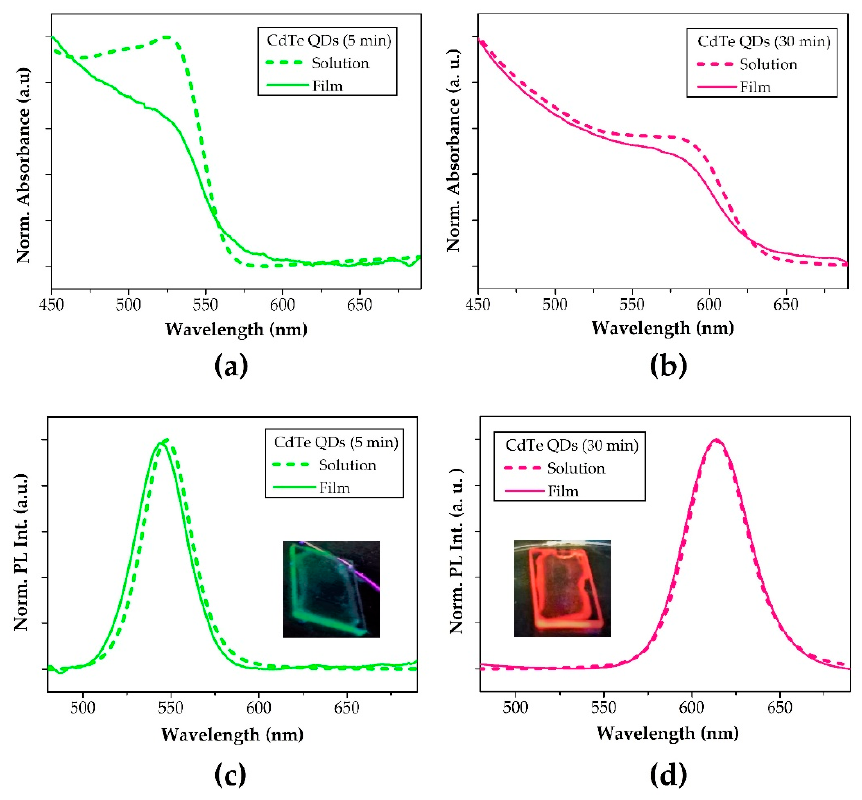
Figure 10. Normalized absorption spectra of the CdTe QDs prepared at 150 °C after 5 ( a ) and 30 ( b ) minutes of annealing in solution (dashed line) and after encapsulation in the polymer (solid line). Normalized PL spectra of the CdTe QDs prepared after 5 ( c ) and 30 ( d ) minutes of annealing in solution (dashed line) and after encapsulation in the polymer (solid line). Inset: photographs of the films acquired under the UV lamp at 365 nm.